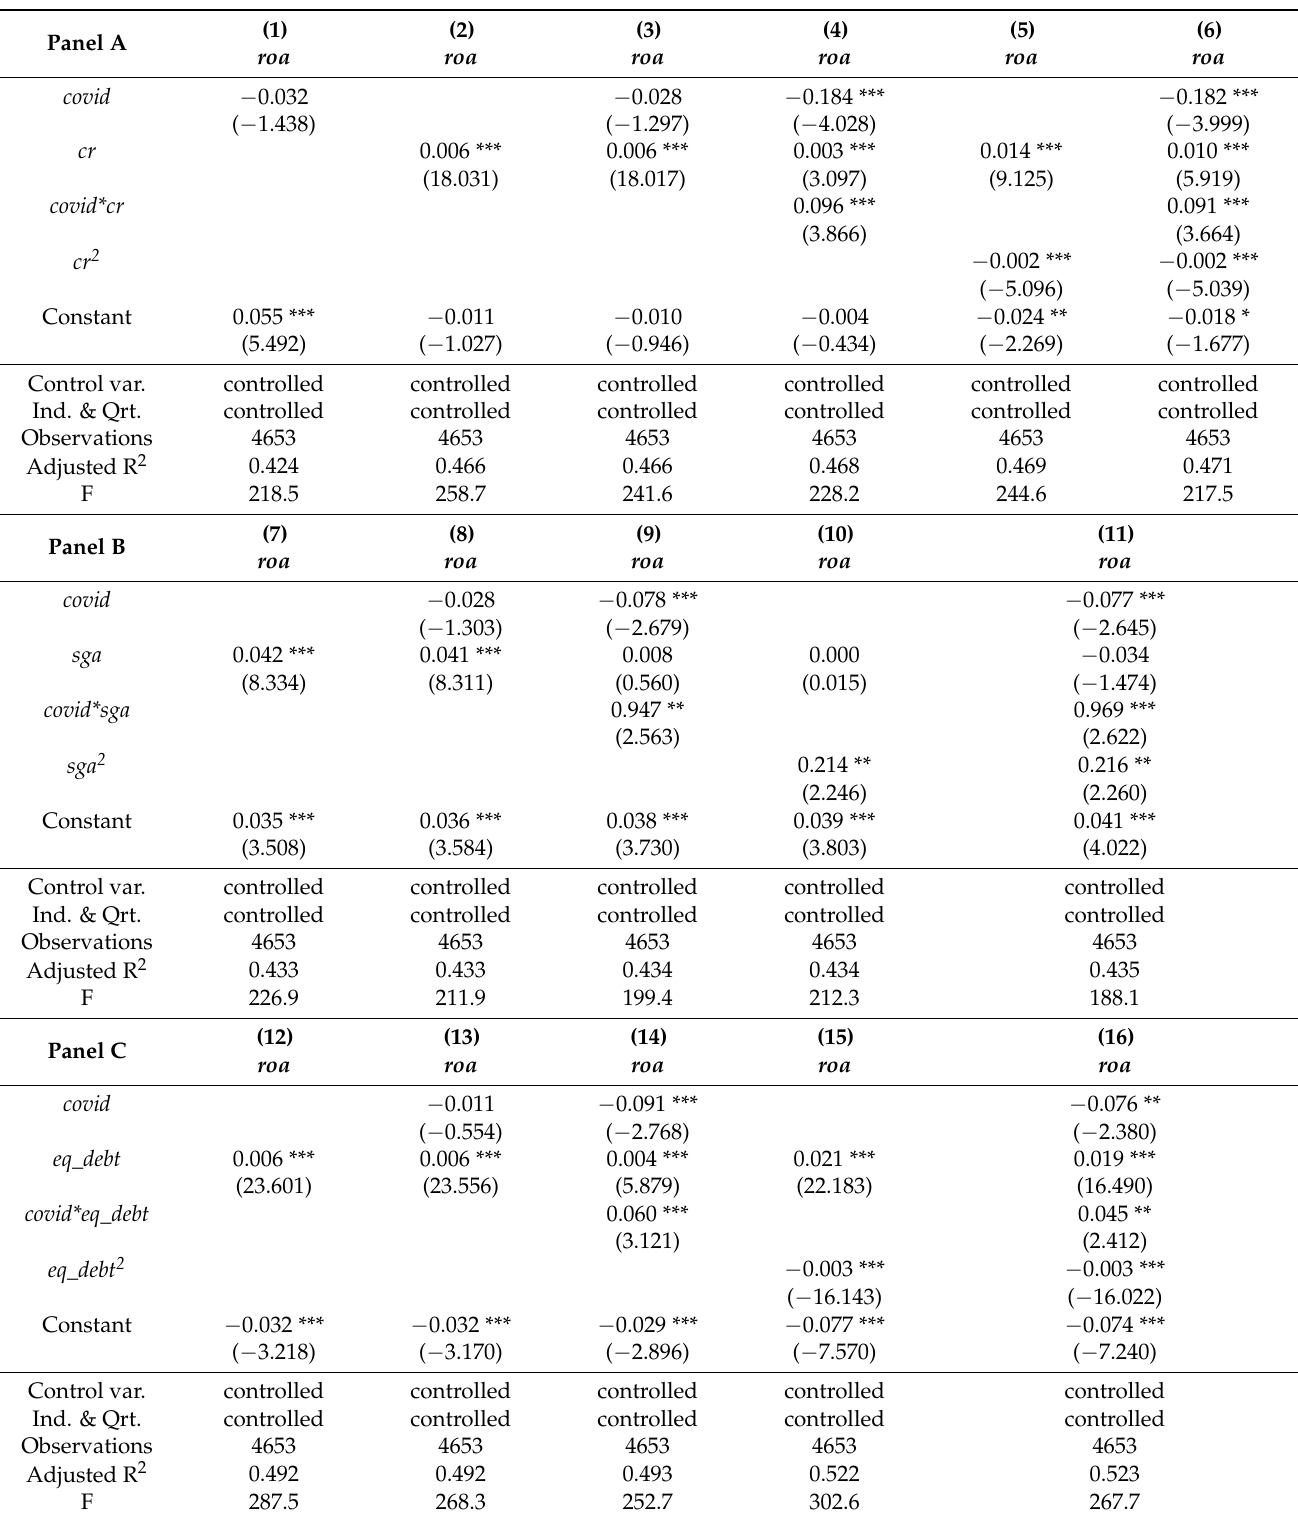
Table 6. Regression Results for H2: Financially constrained